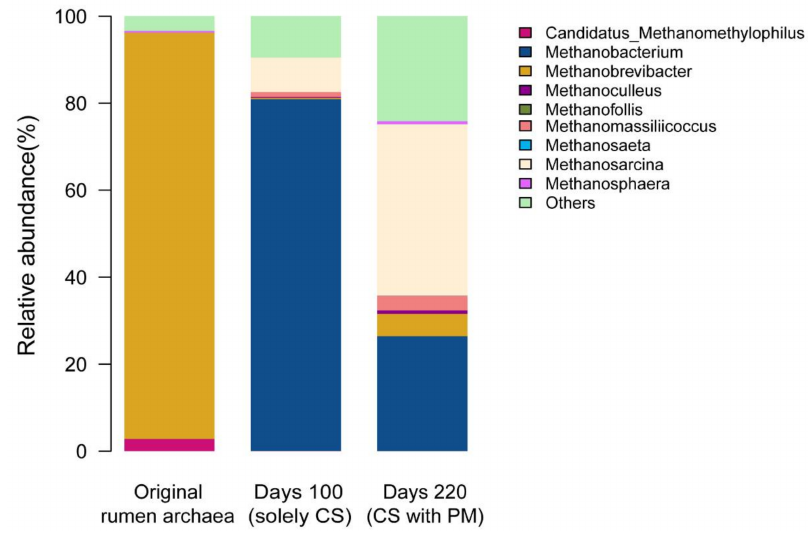
Figure 5. Composition of the archaeal community at the genus